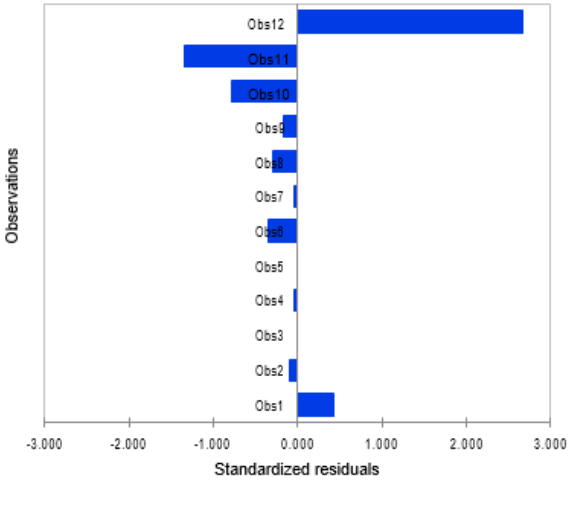
Figure 11: Standardized residuals / Y Model N/m 2